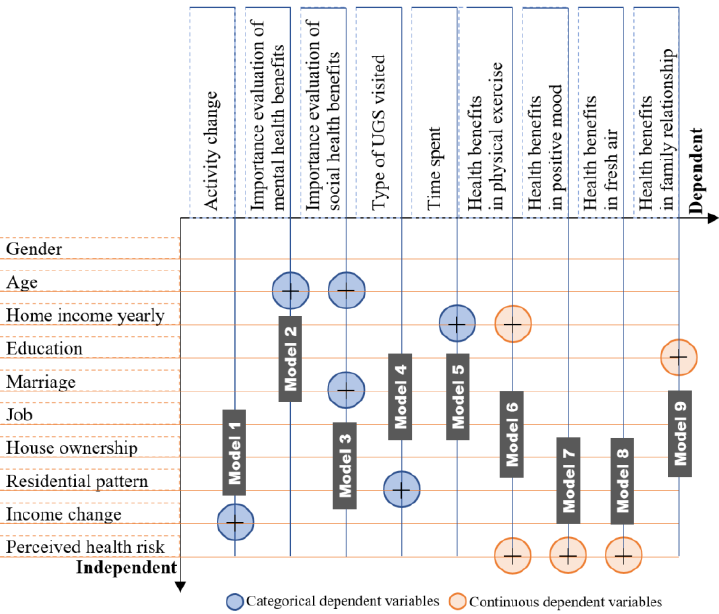
Figure 7. Significant associations between demographic characteristics and usage and perception of UGSs according to Chi-square tests. (Models 1 – 9 are built for the following logistic regression analysis.).